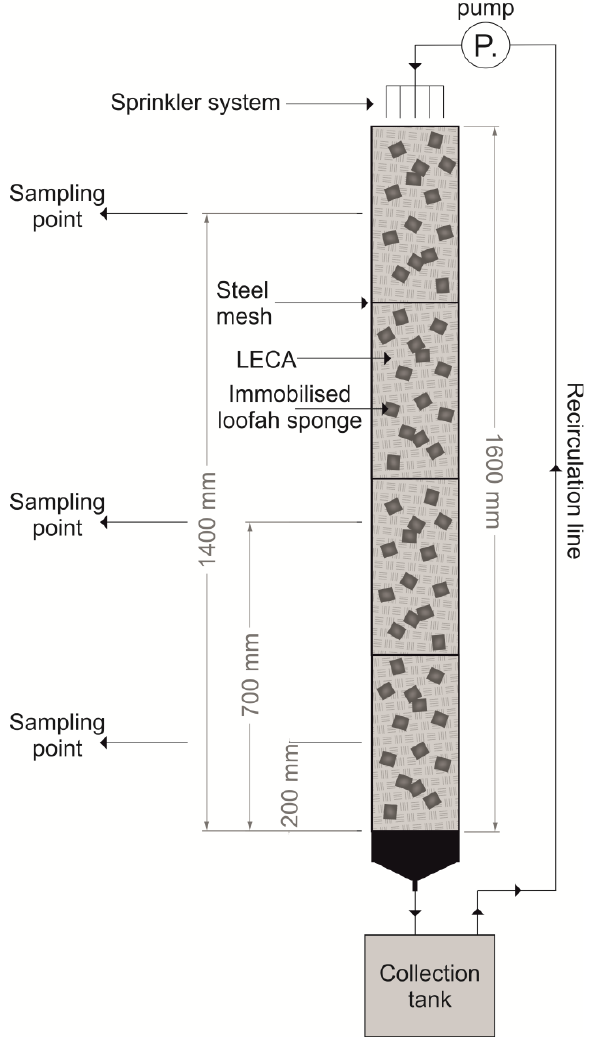
Figure 4. Experimental set- up of the trickling filters.